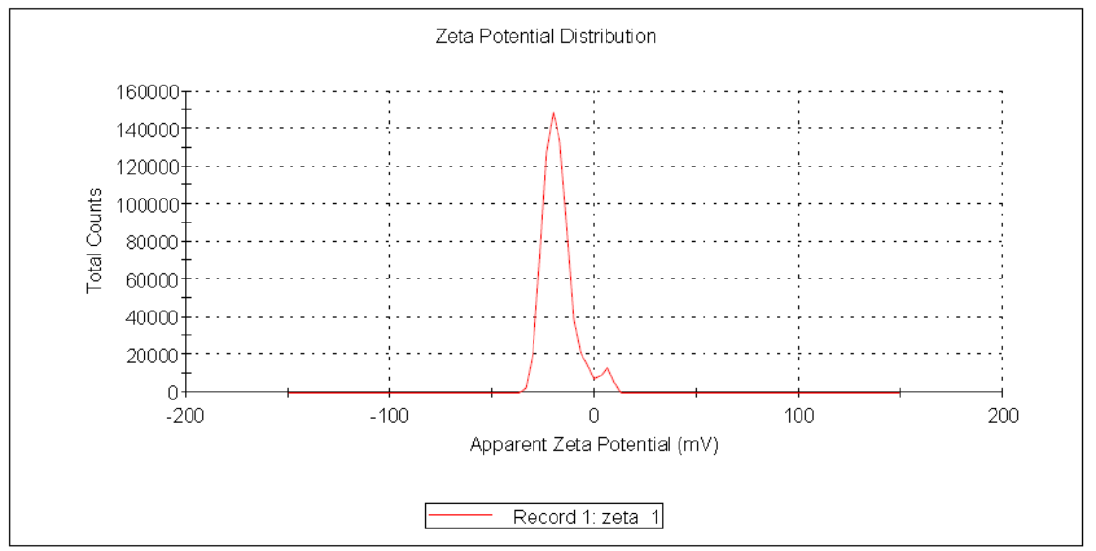
Fig. 8. Zeta potential of the USeNPs Figure 8. Zeta potential of the